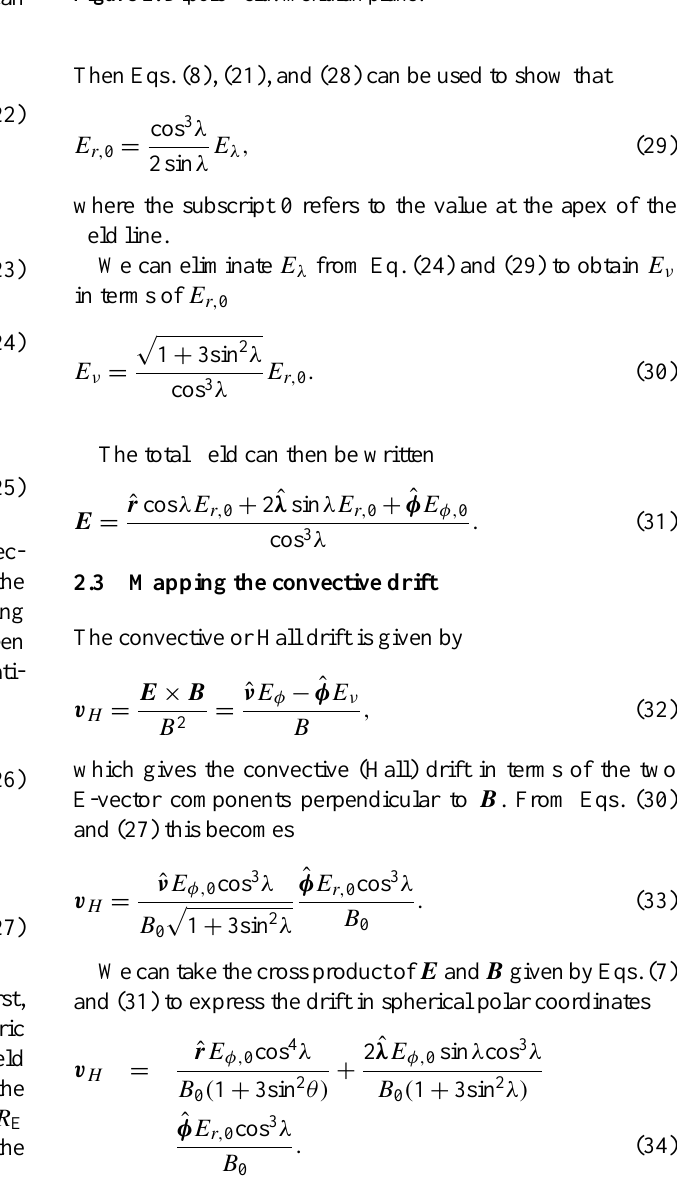
Figure 2. Dipole field: meridian